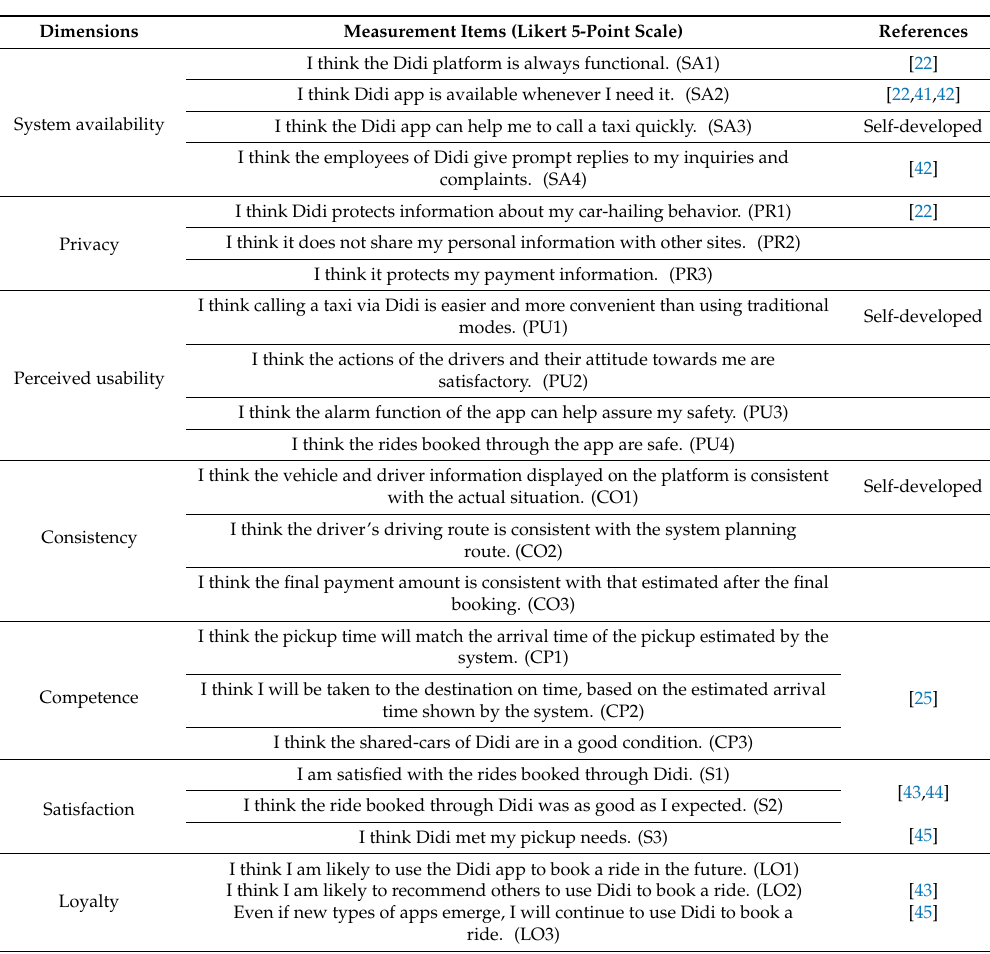
Figure 1. Model of study. Table 1. Measurement